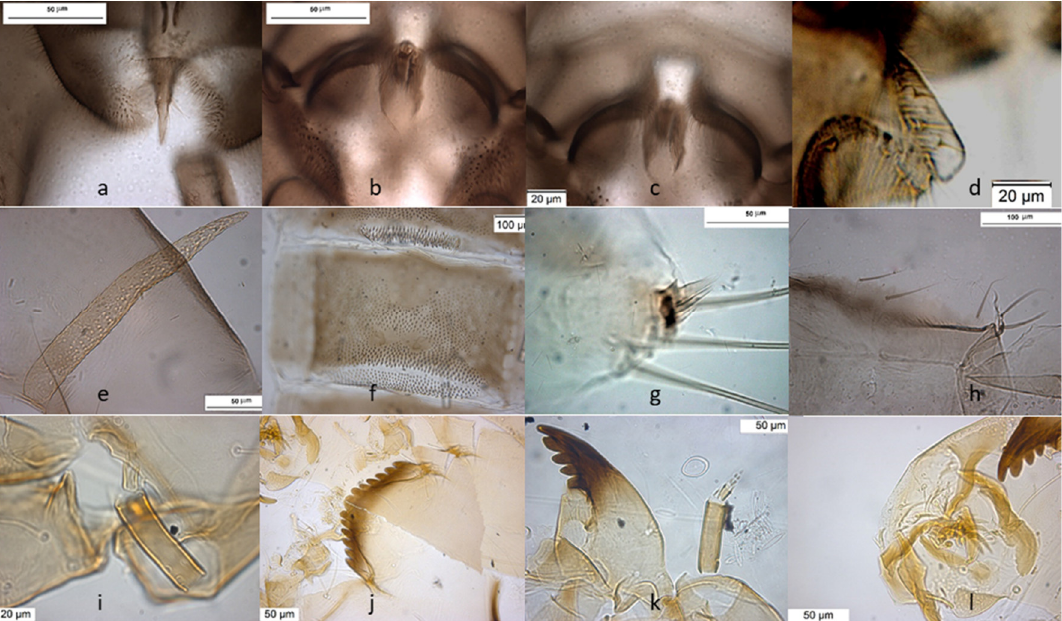
Figure 1. Morphological characters of O. ( O. ) excavatus adult male: ( a ) anal point; ( b ) virga; ( c ) superior volsella; ( d ) inferior volsella; pupal exuviae: ( e ) thoracic horn, ( f ) tergite III; ( g ) taeniate extensions; ( h ) tergite VIII; larva: ( I ) antenna; ( j ) mentum; ( k ) mandible; ( l ) labrum.